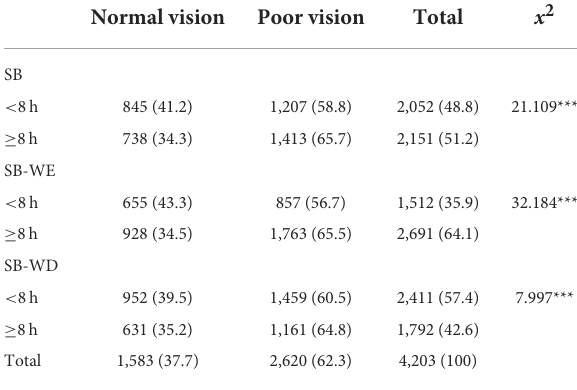
TABLE 17 Differences in the detection rate of high sedentary behavior among children and adolescents with different vision conditions [ n